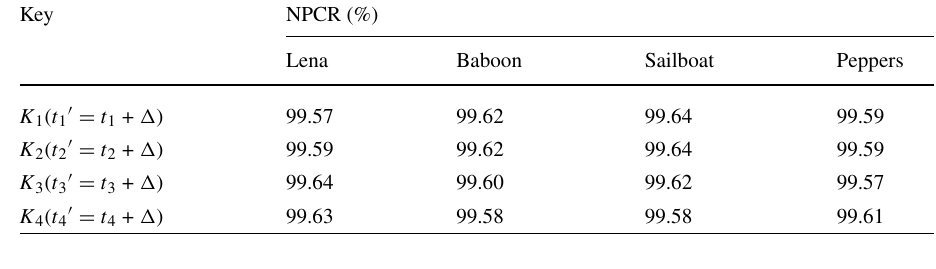
Table 9 The NPCR between two deciphered images Key NPCR (%)